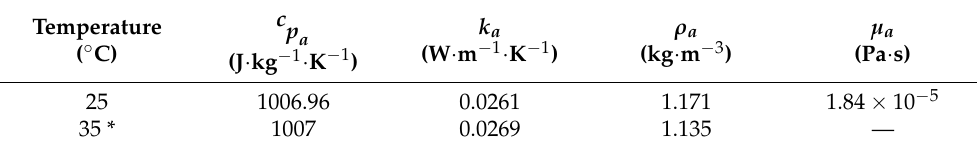
Table 2. Air thermo-physical properties at 25 ◦ C based on what was reported in [30]. Temperature